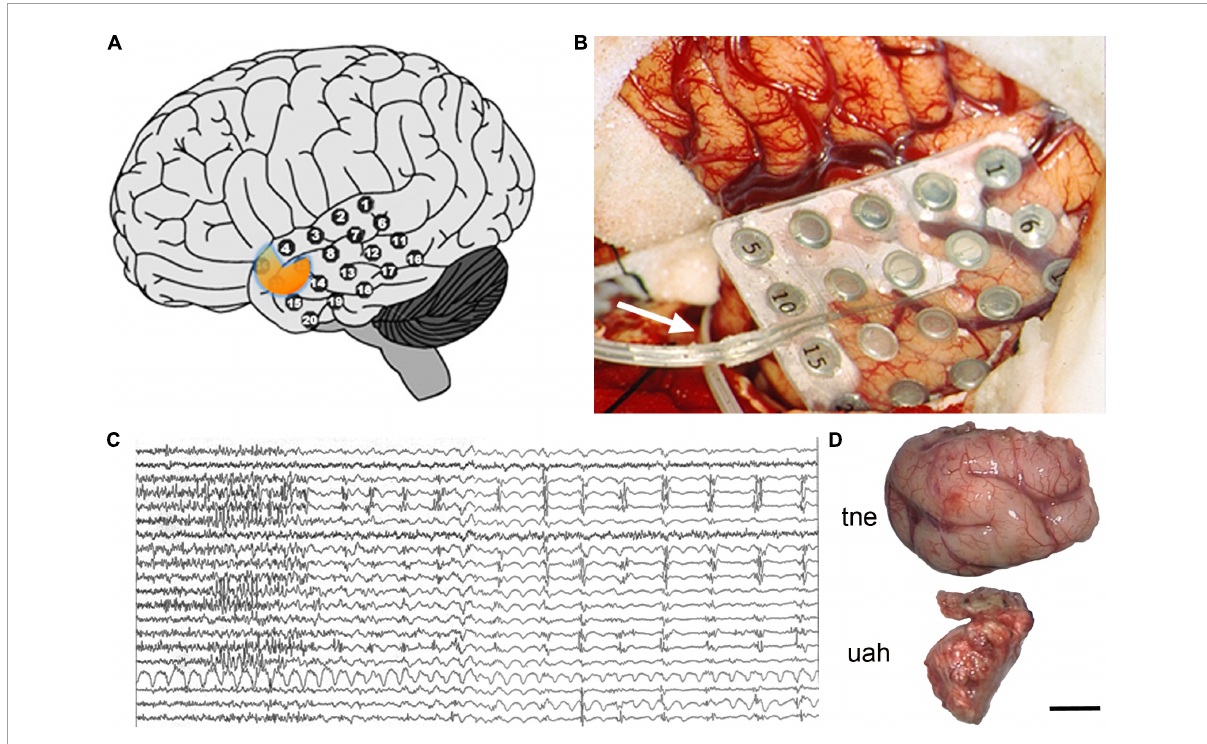
FIGURE2 Surgical procedure. (A,B) 20-electrode grid over the left temporal neocortex and a strip of 8 electrodes, entering through the base of the lateral (Sylvian) sulcus [arrow in panel (B) ], to be placed between the tentorium cerebelli and the uncus-parahippocampal gyrus. (C) Electrocorticographic (EcoG) recording after pharmacological stimulation with etomidate. (D) Image of the en-bloc resection of the temporal neocortex (tne) and the uncus-amygdala-hippocampal complex (uah). The orange area in panel (A) illustrates the approximate location of the amygdala and head of the hippocampus. Scale bar: 10 mm.